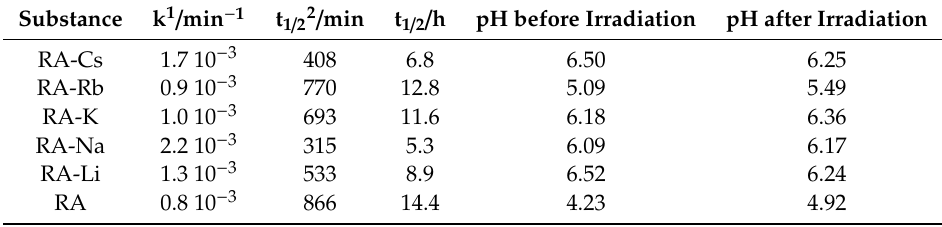
Table 7. The results of kinetics studies of photolysis of direct rosmarinic acid and its alkali metal